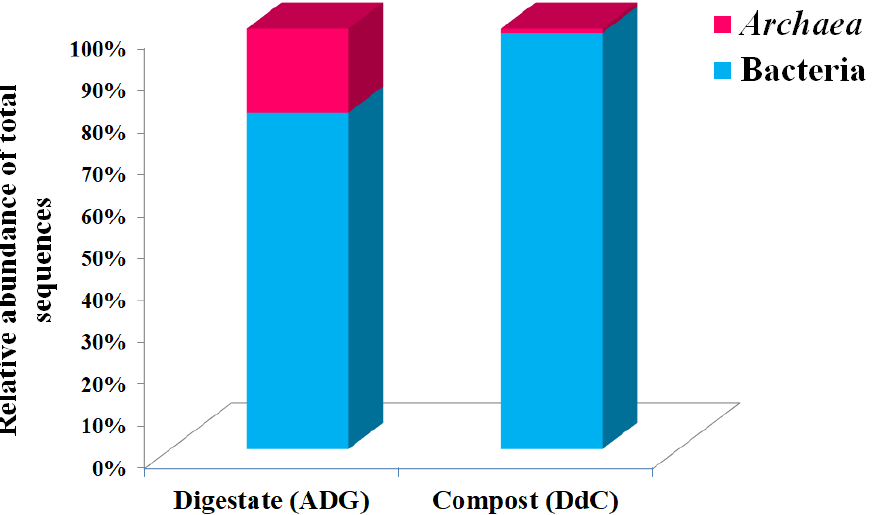
Figure 1. Relative abundance (RA%) of Bacteria and Archaea in digestate (ADG) and compost (DdC). The taxonomic assignments were obtained from 16S rRNA gene sequencing analysis.